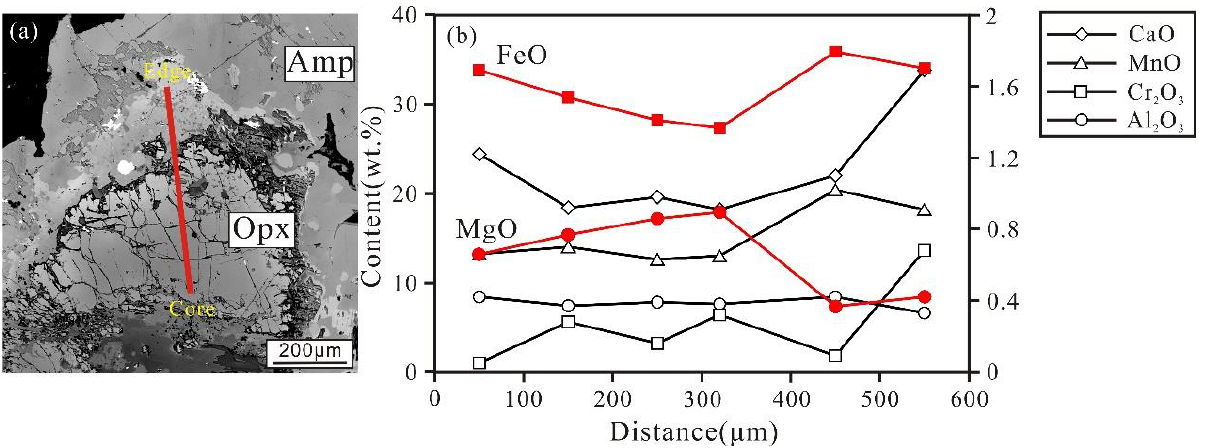
Figure 9. ( a ) BSE images of an orthopyroxene phenocryst in graphite orbicule. ( b ) Compositional variations along the profile of the Huangyangshan orthopyroxene phenocryst (based on the data from Table S4).